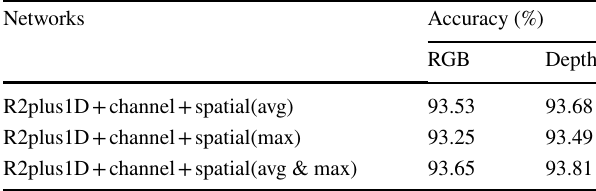
Table 3 Comparison methods of pooling mode on EgoGesture [12]